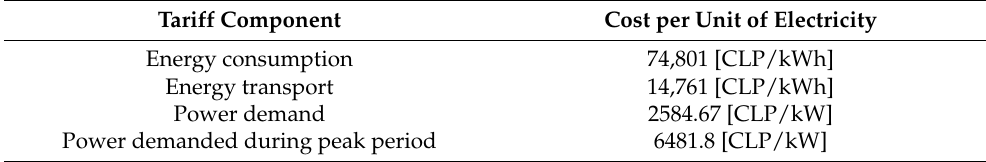
Table 12. Cost components of electricity in Chilean pesos [CLP].